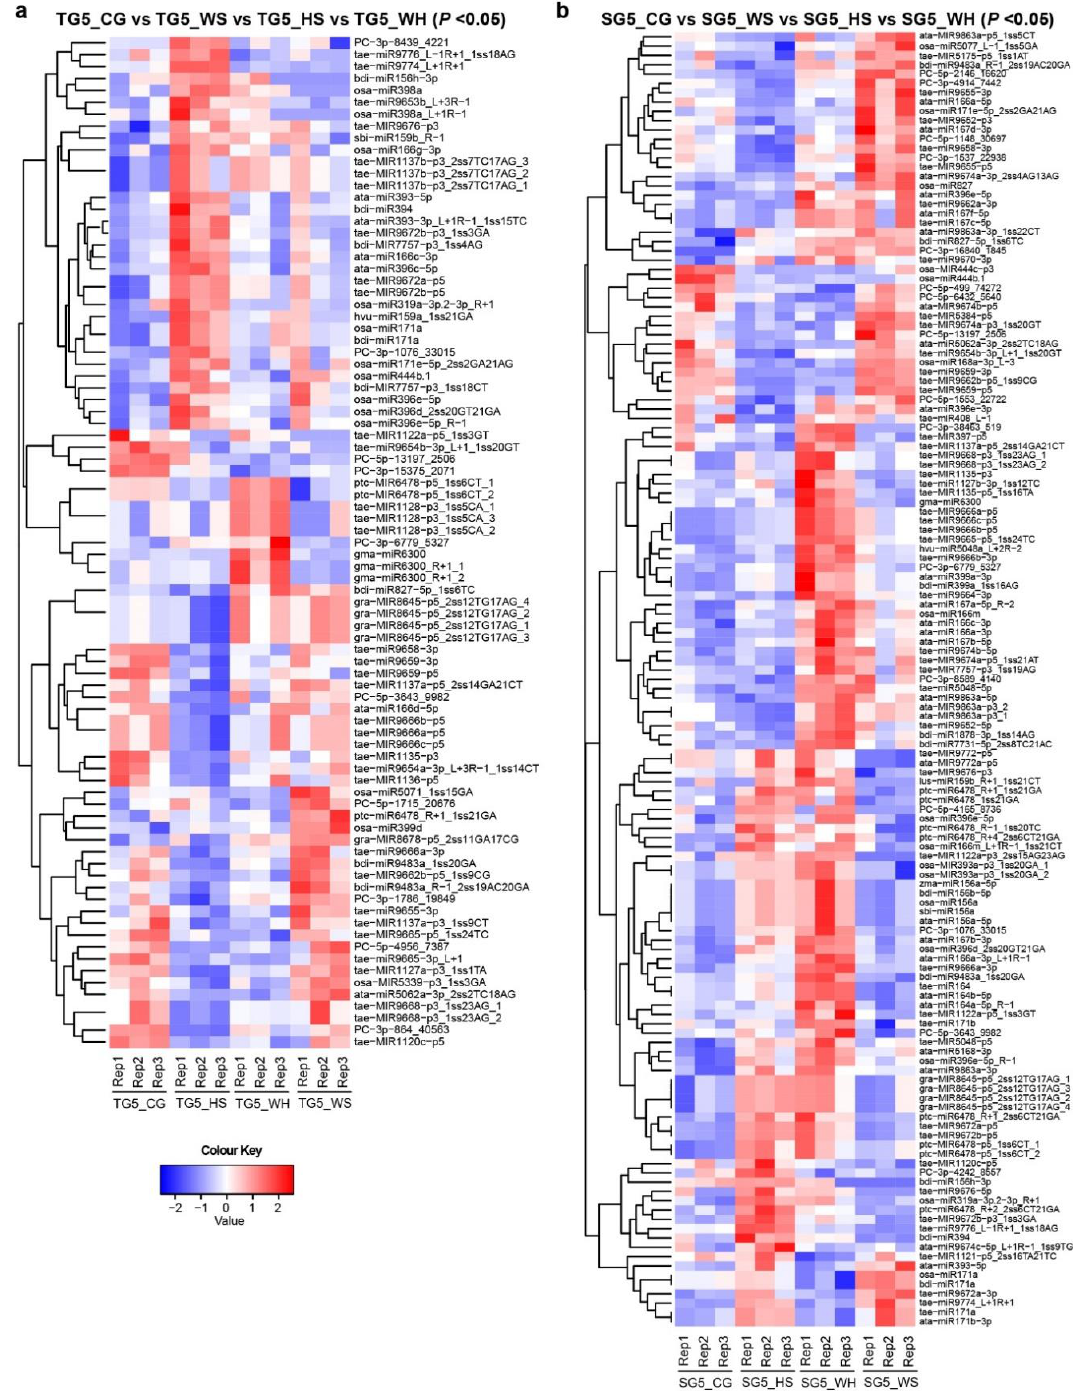
Figure 2. Heat maps showing differentially expressed miRNAs (DEMs) at 5 DPA across four treatment groups. ( a ) DEMs ( p < 0.05) in DBA Aurora (TG5_CG vs. TG5_WS vs. TG5_HS vs. TG5_WH). ( b ) DEMs ( p < 0.05) in L6 (SG5_CG vs. SG5_WS vs. SG5_HS vs. SG5_WH). The color key representing miRNA expression level is shown as the log 10 value of the normalized read count. Figure S2 provides heat maps showing DEMs at 15–45 DPA. TG, libraries made from developing grains of the stress-tolerant genotype DBA Aurora. SG, libraries made from developing grains of the stress- sensitive genotype L6. The DPA value of 5 stands for the time-point of sampling. CG, control group. WS, water deficit stress group. HS, heat stress group. WH, water deficit plus heat stress group.